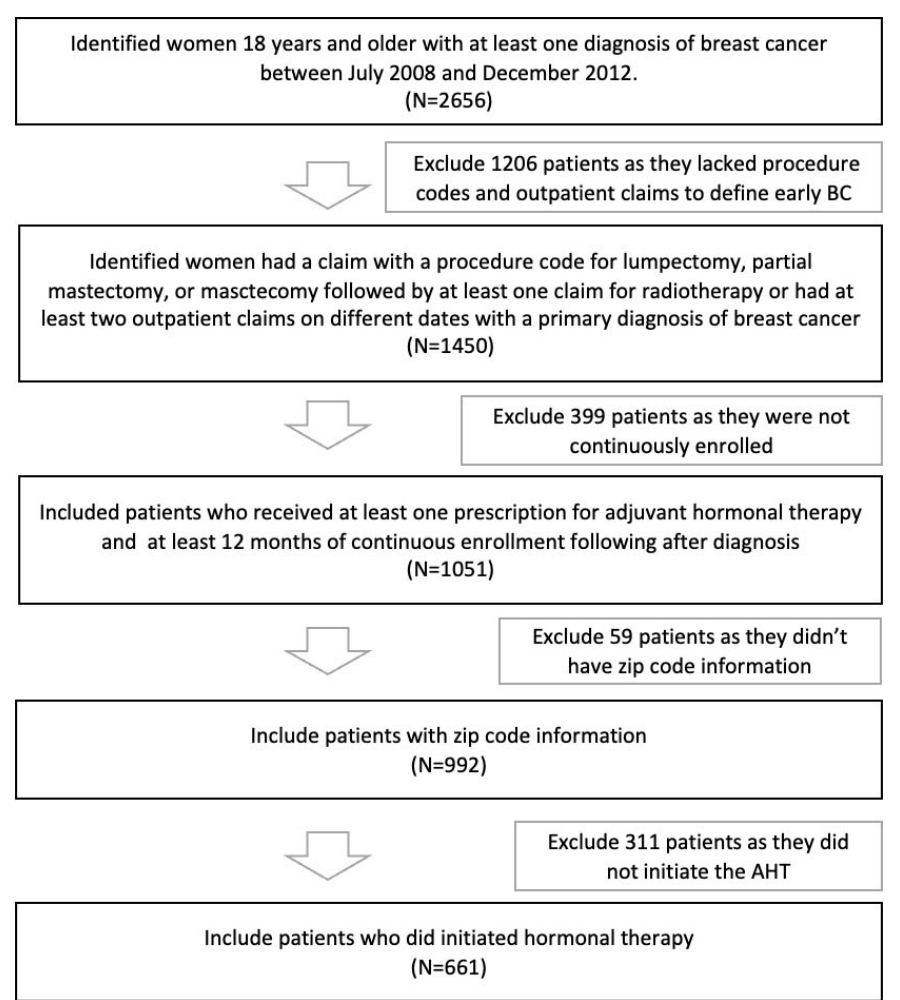
Figure 1. Steps of Inclusion/Exclusion Criteria. Table 1. Descriptive statistics for the study cohort.